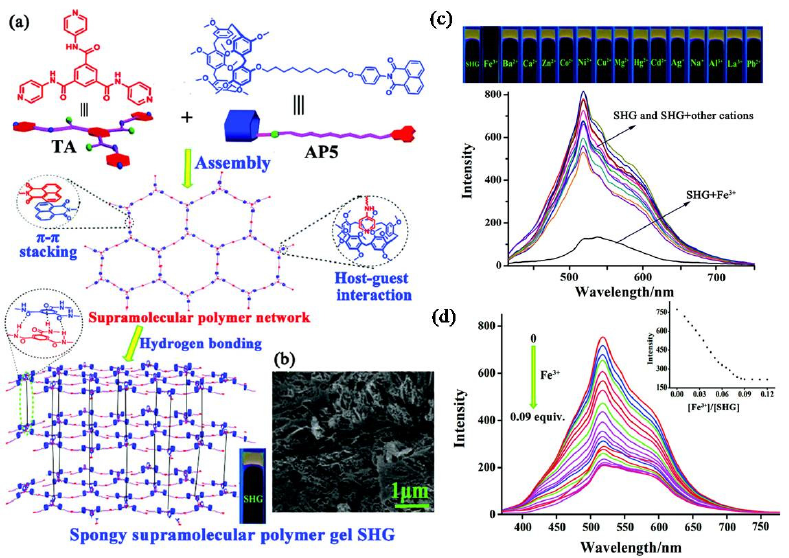
Figure 8. ( a ) Host and guest molecule chemical structure and proposed assembly mechanism into supramolecular polymer gels (SHGs) ( b ) SEM images of SHGs. ( c ) Top: images of SHG and different cations mixture under UV irradiation; bottom: fluorescence spectra of SHG with addition of different cation aqueous solutions. ( d ) Fluorescence spectra of SHG with increasing concentrations of Fe 3+ ( λ ex = 280 nm, λ em = 520 nm). Reprinted with permission from Ref. [62]. Copyright 2019, Royal Society of Chemistry.